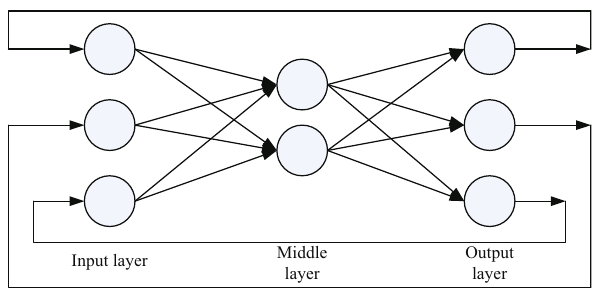
Figure 7: Feedback - forward network